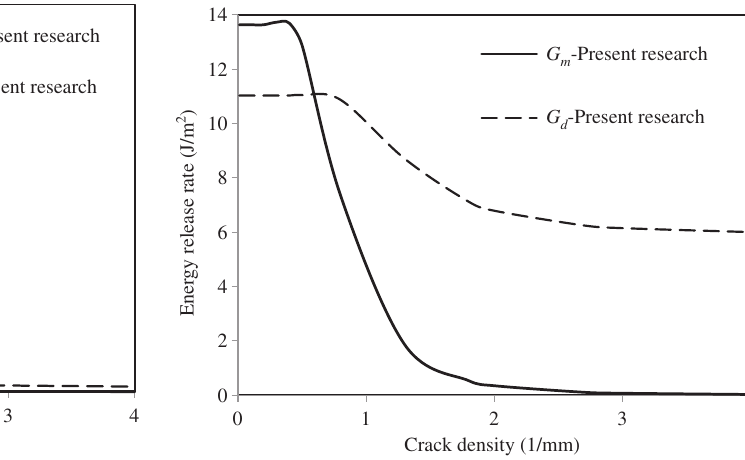
Figure 8: Crack density vs. energy release rate for [0/90 epoxy laminate under σ